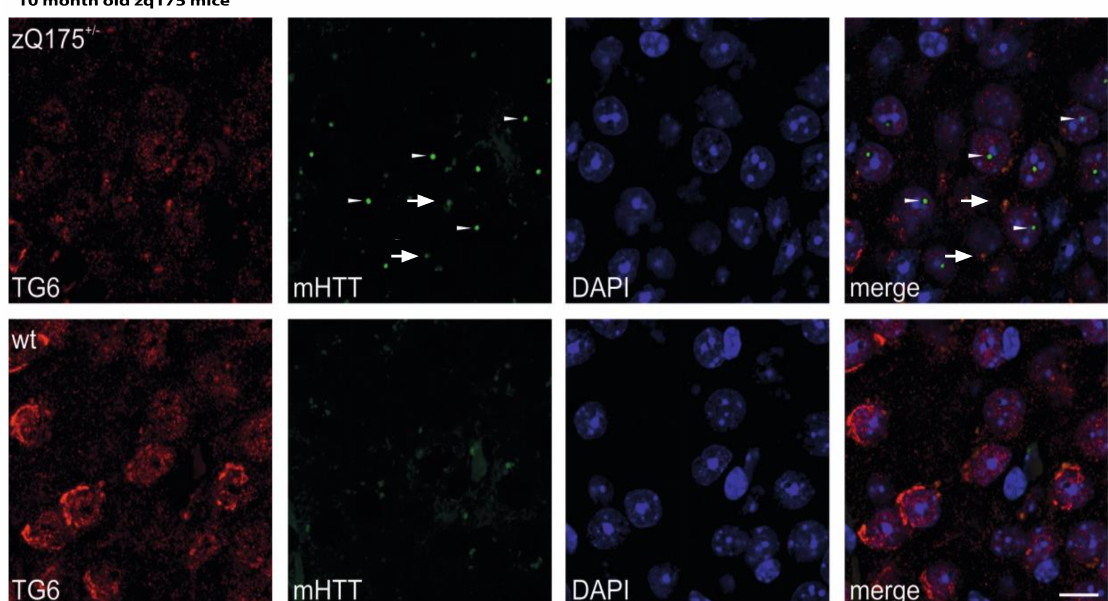
Figure 4. mEM48-immunopositive mHTT aggregates colocalize with TG6. Immunolabeling of brain sections from zQ175DN KI mice with the mEM48 antibody revealed a pronounced and punctuate nuclear staining, particularly in the cortex and the striatum of this HD knock-in mice. Some cells in these areas also showed a colocalized intracellular staining signal with the TG6 isoform (arrows) and mHTT inclusions, as detected with the respective antibodies. Additionally, the TG6 immunolabeling differs between the two genotypes, being more prominent contiguous to the nuclear membrane in wildtype animals. Scale bar: 10 µ